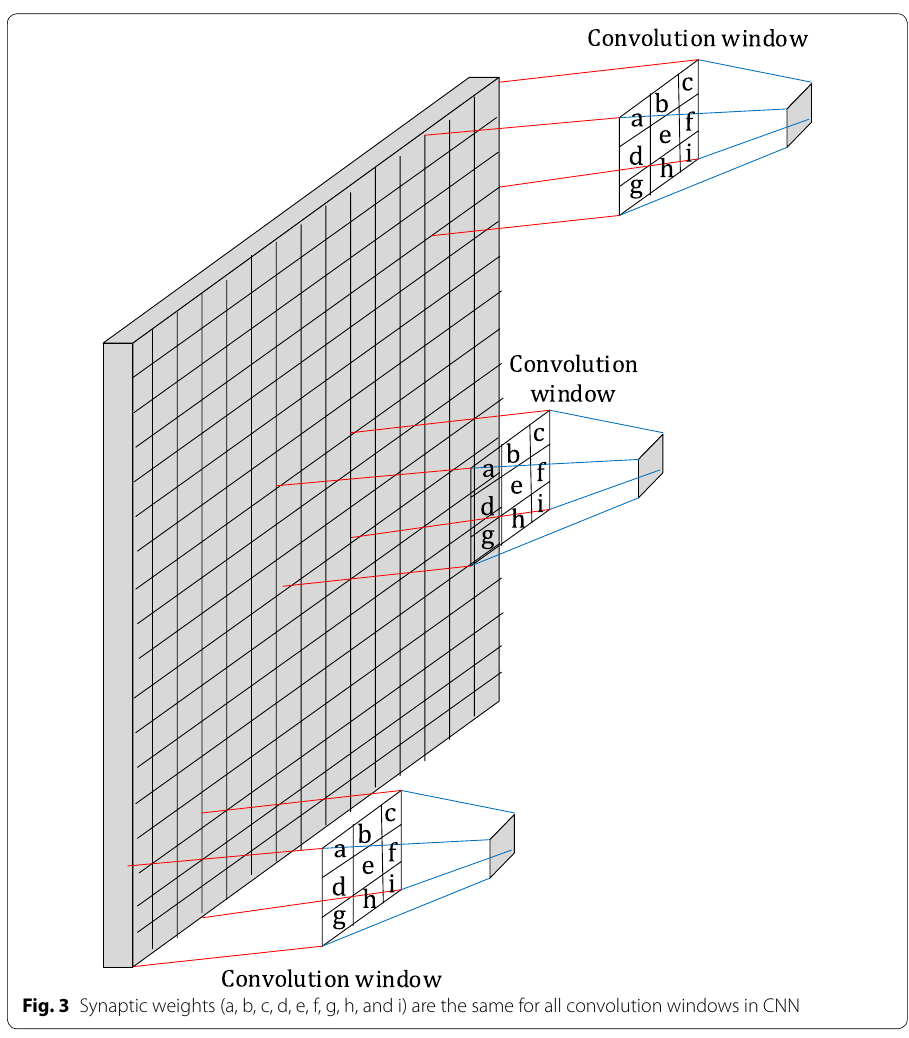
Fig. 3 Synaptic weights (a, b, c, d, e, f, g, h, and i) are the same for all convolution windows in